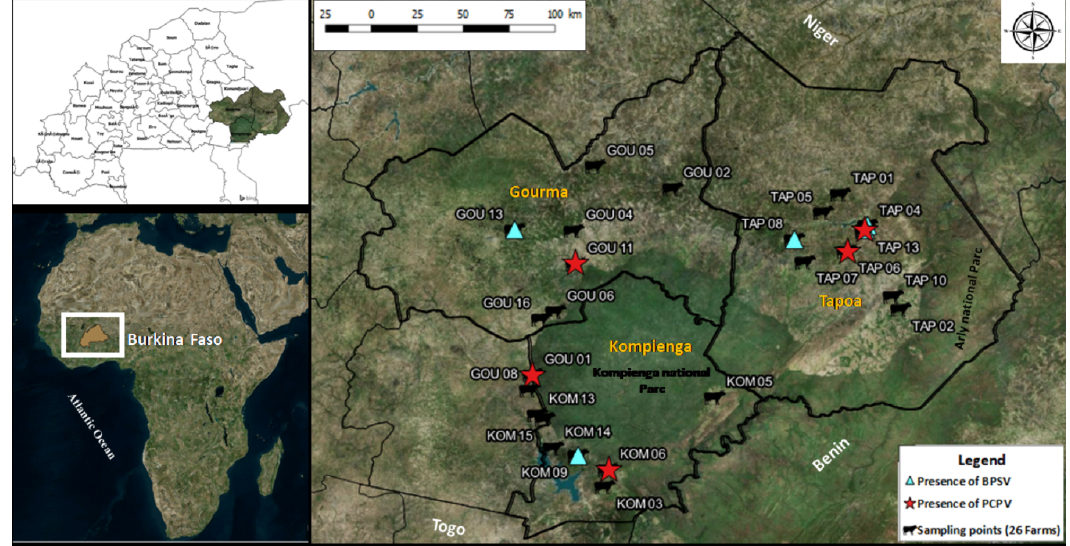
Figure 1. Localization of tick collection and positive pools of ticks in the study area (Eastern Burkina Faso) Gou: Gourma; Kom: Kompienga; Tap: Tapoa.